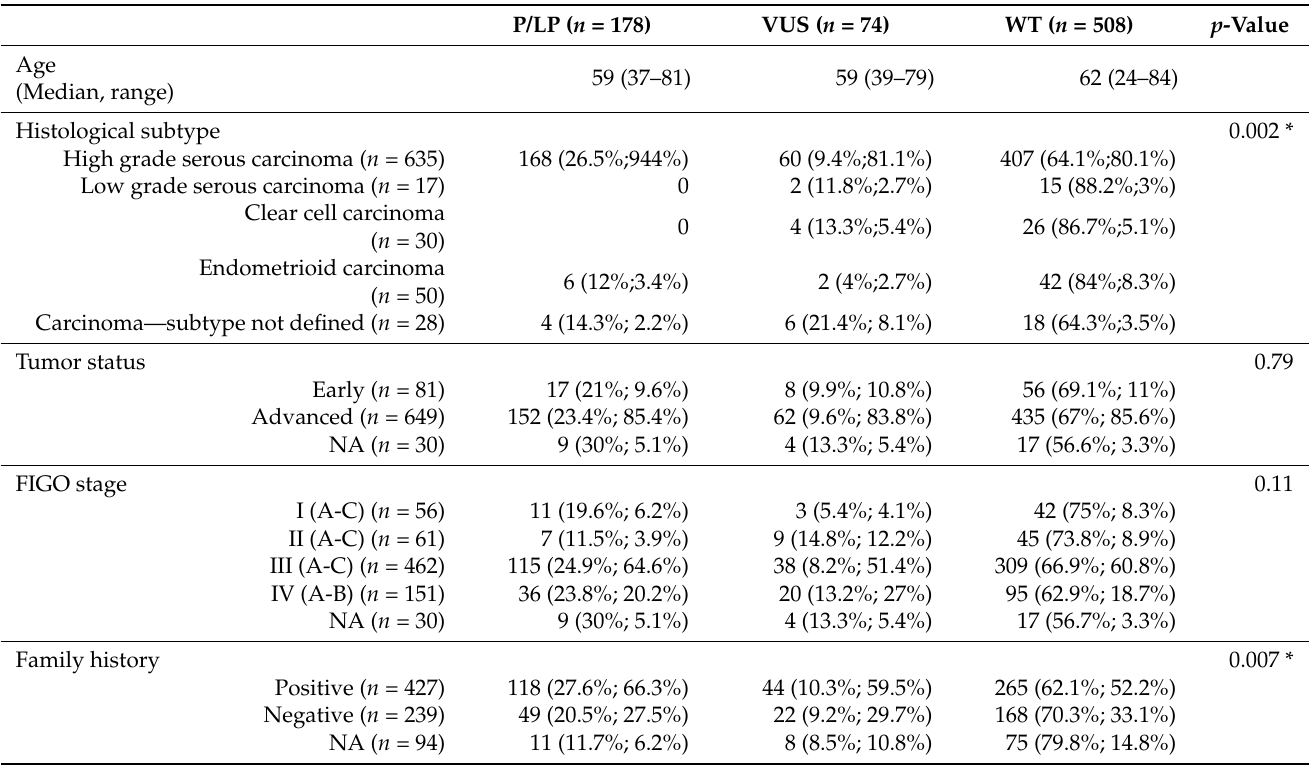
Table 3. Clinicopathological features by BRCA status in the present cohort (N = 760). Number of cases (percentage row; percentage column). P/LP: pathogenic/likely pathogenic variants; VUS: variants